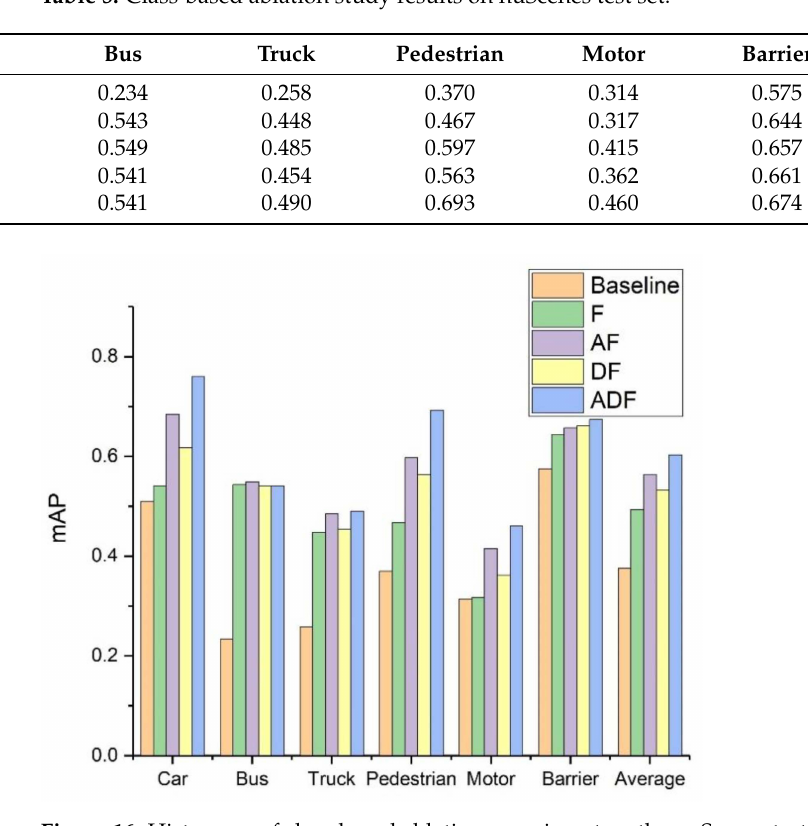
Figure 16. Histogram of class-based ablation experiment on the nuScenes test